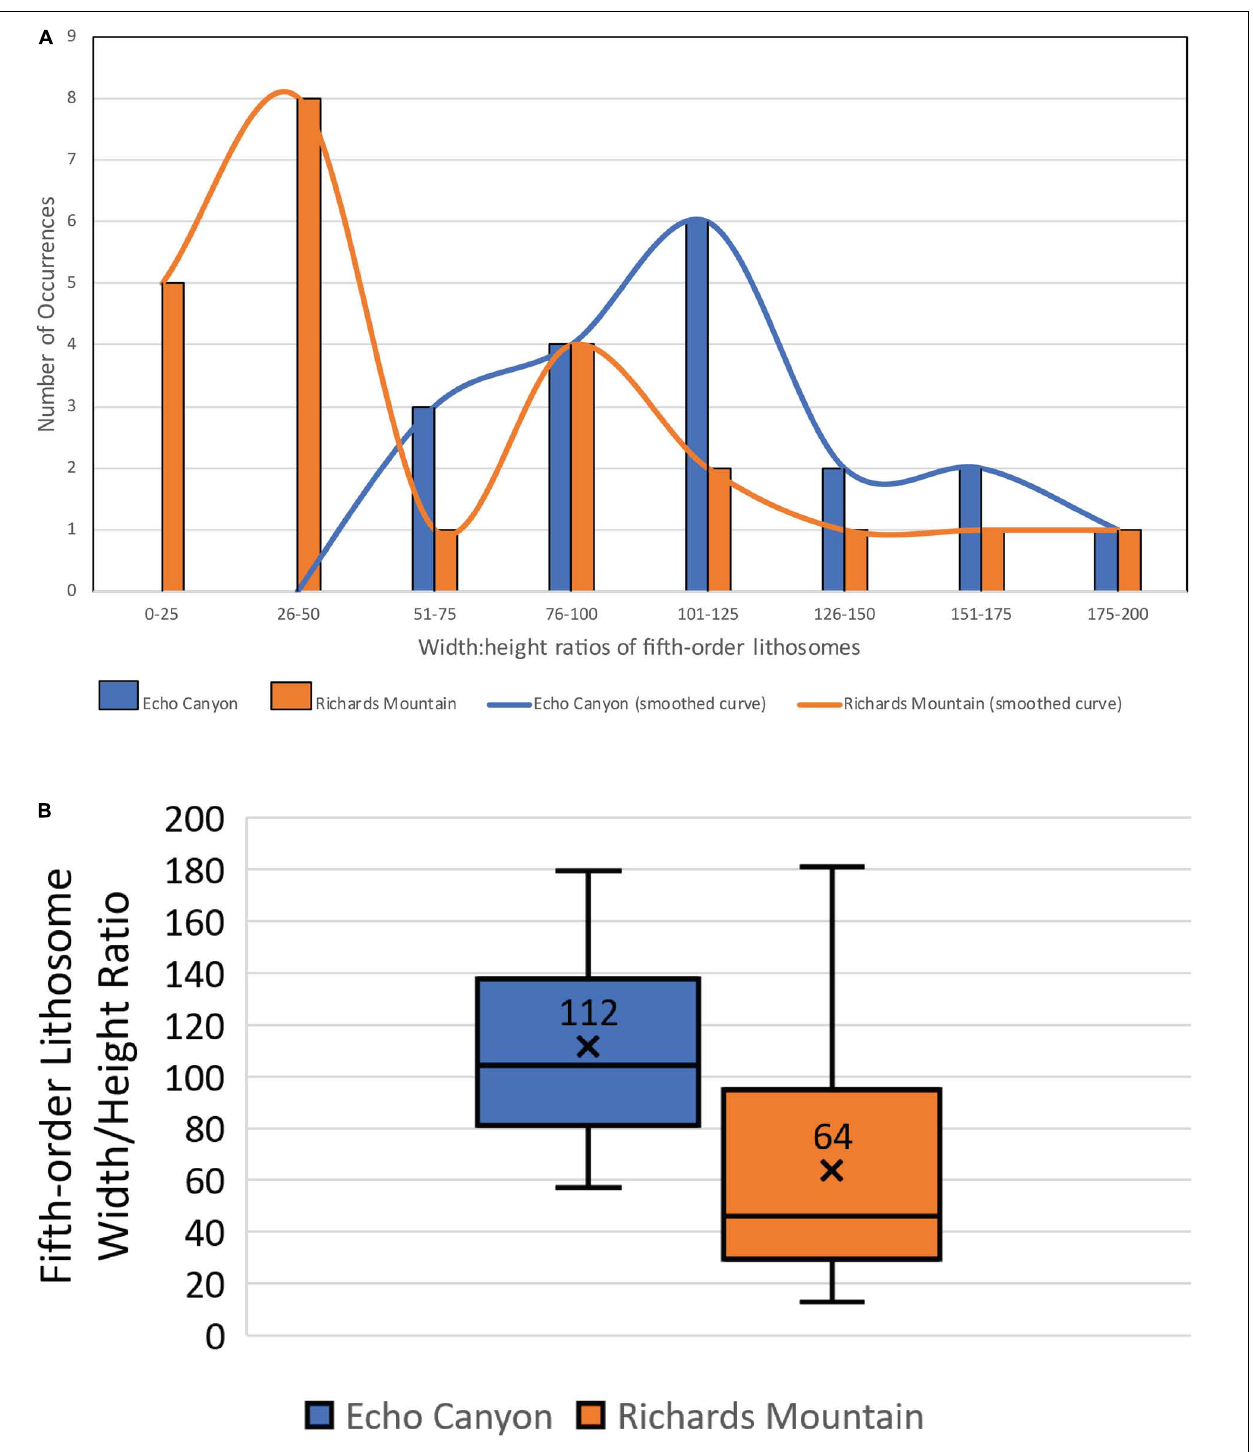
FIGURE 11 | Statistical summary of width:height ratios of fifth-order lithosomes in the Echo Canyon Conglomerate and the Richards Mountain Conglomerate. Lithosome widths were corrected where necessary for oblique exposure angles. Height was measured at the point of maximum observed thickness. A two-sample t -test (one-tailed) showed that these ratios were significantly larger at Echo Canyon ( M = 112, SD = 37) than at Richards Mountain ( M = 64, SD = 37), t (39) = 3.46, p = 0.0007. (A) Distribution of fifth-order width:height ratios. Lines represent a smoothed curve of the distributions. Note that Echo Canyon width:height ratios tend to be larger than those at Richards Mountain. (B) Box-and-whisker plots showing range of width:height ratios for fifth-order lithosomes in the Echo Canyon and Richards Mountain Conglomerates. “X” indicates average. Note that average width:height ratios for fifth-order lithosomes in the Echo Canyon Conglomerate are nearly twice those observed in the Richards Mountain